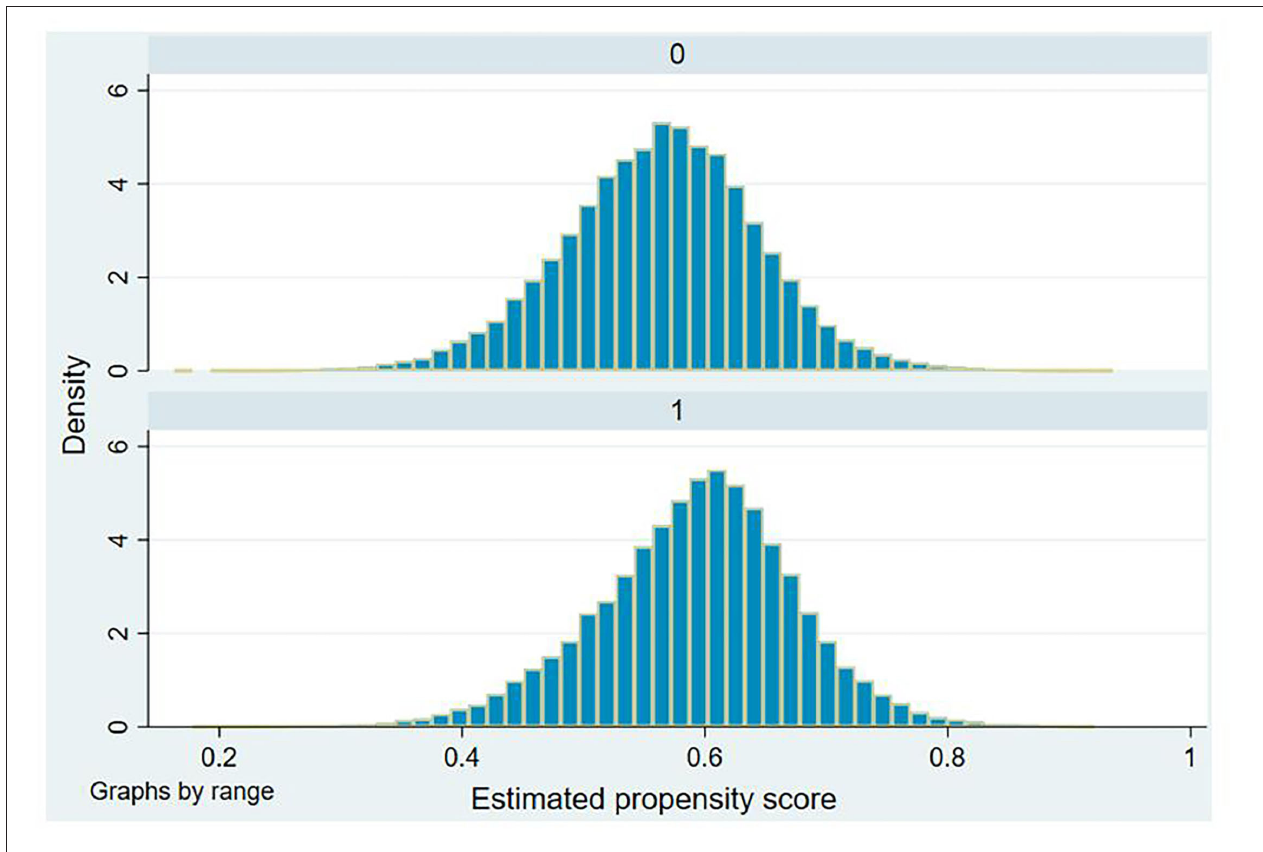
FIGURE 3 | Density distribution of the propensity score.